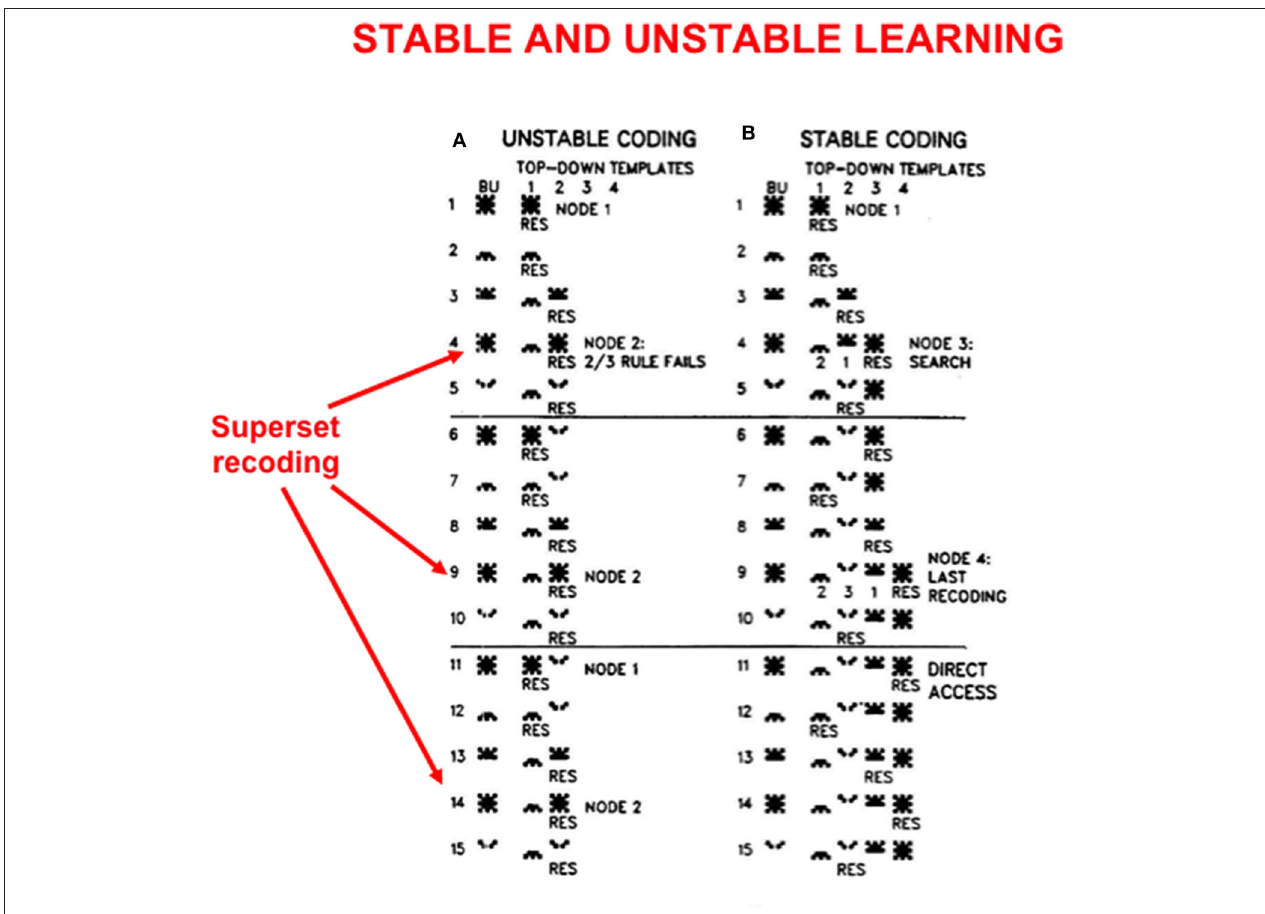
FIGURE 6 | These computer simulations illustrate how (A) unstable learning and (B) stable learning occur in response to a particular sequence of input vectors A, B, C, D when they are presented repeatedly in the order ABCAD to an ART 1 model. Unstable learning with catastrophic forgetting of the category that codes vector A occurs when no top-down expectations exist, as illustrated by its periodic recoding by categories 1 and 2 on each learning trial. See the text for details [adapted with permission from Carpenter and Grossberg